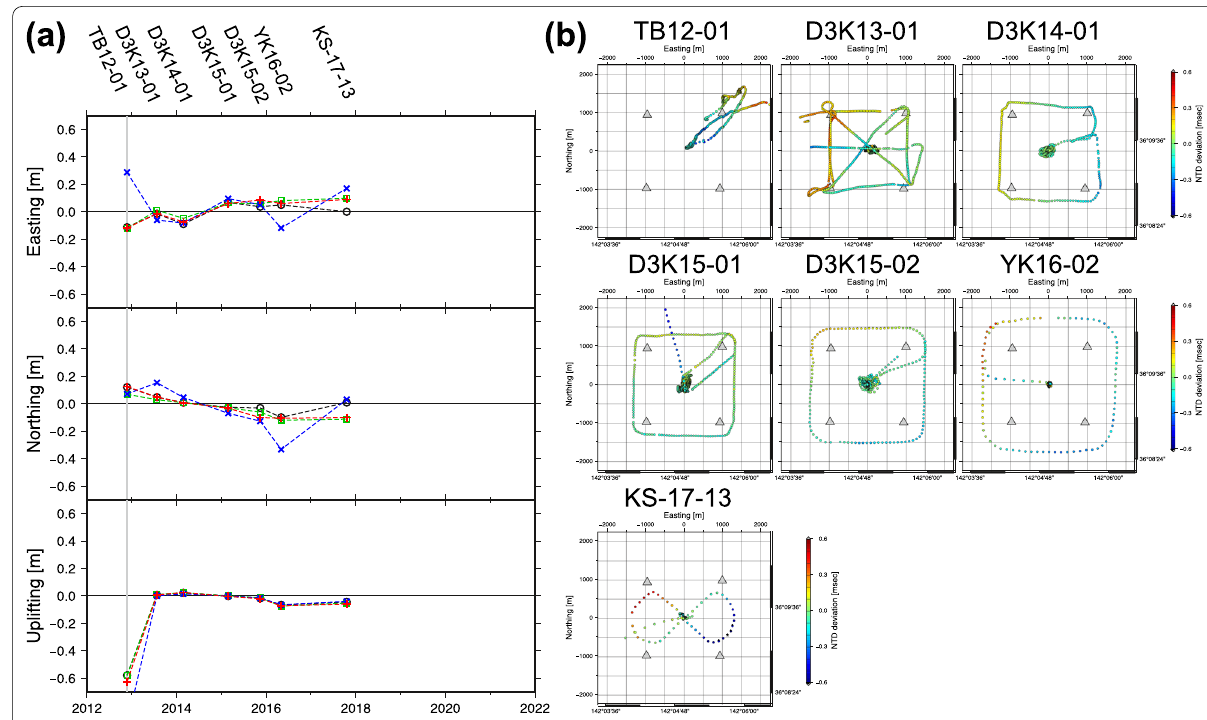
Fig. 8 Time-series of the array positions and sea-surface tracks for campaigns at G20. a Time-series of the array positions. Open black circles, blue x-marks, red crosses, open green squares show the solutions estimated using Method-1, Method-2, Method-3, and Method-4, respectively. b Sea-surface platform positions when the acoustic signals were transmitted. The colors show NTDs subtracting the long-term fluctuation of NTDs estimated by